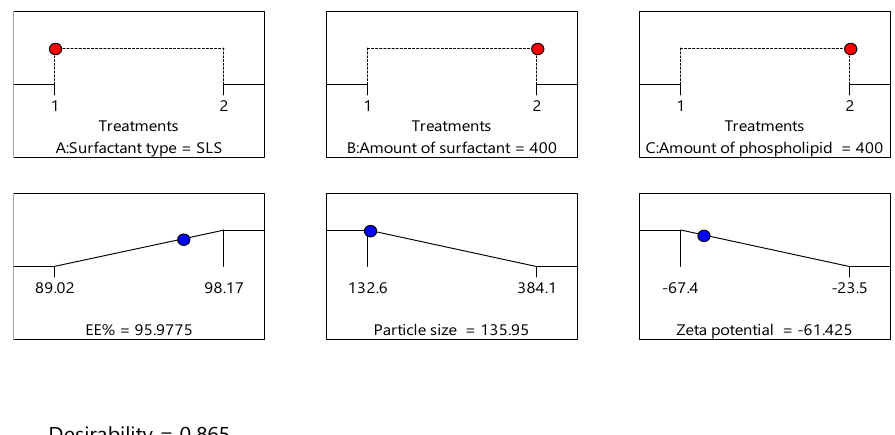
Figure 5 . The independent (red color) and dependent variables (blue color) of optimized ITZ- TFS4 .